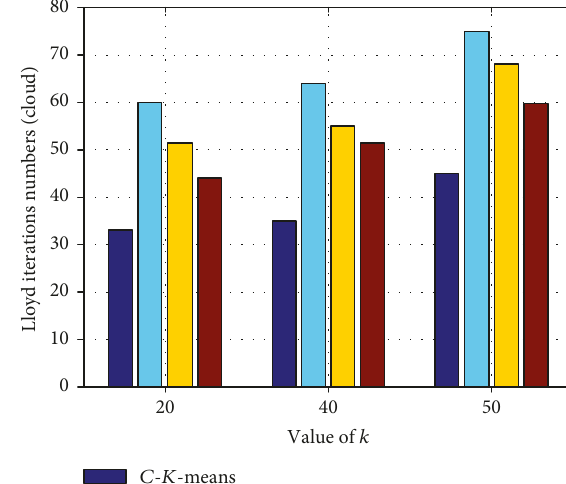
Table 8: Accuracy comparison (Cloud).